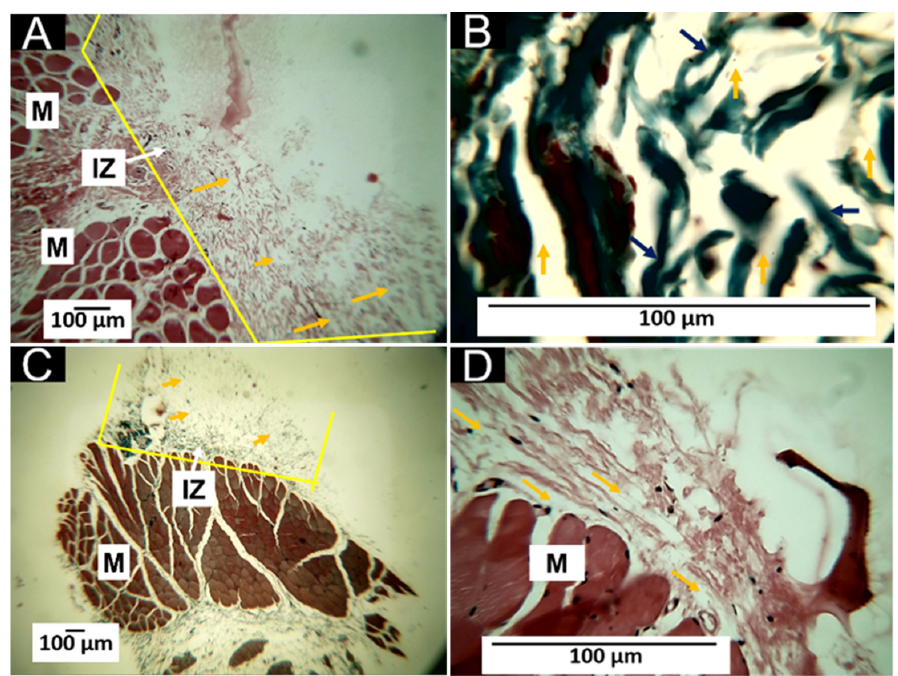
Figure 8. Subdermal implantations of formulation T2, 25%G:75%CS. ( A ): Implantation at 30 days, the image at 10×, H&E technique. ( B ): Implantation at 30 days, the image at 100×, MT technique. ( C ): Implantation at 60 days, 4× image, H&E technique. ( D ): Implantation at 60 days, the image at 40×, H&E technique. M: muscle. IZ: implantation zone. Yellow arrow: fragments of the biomaterial. Blue arrows: connective tissue (type I collagen).